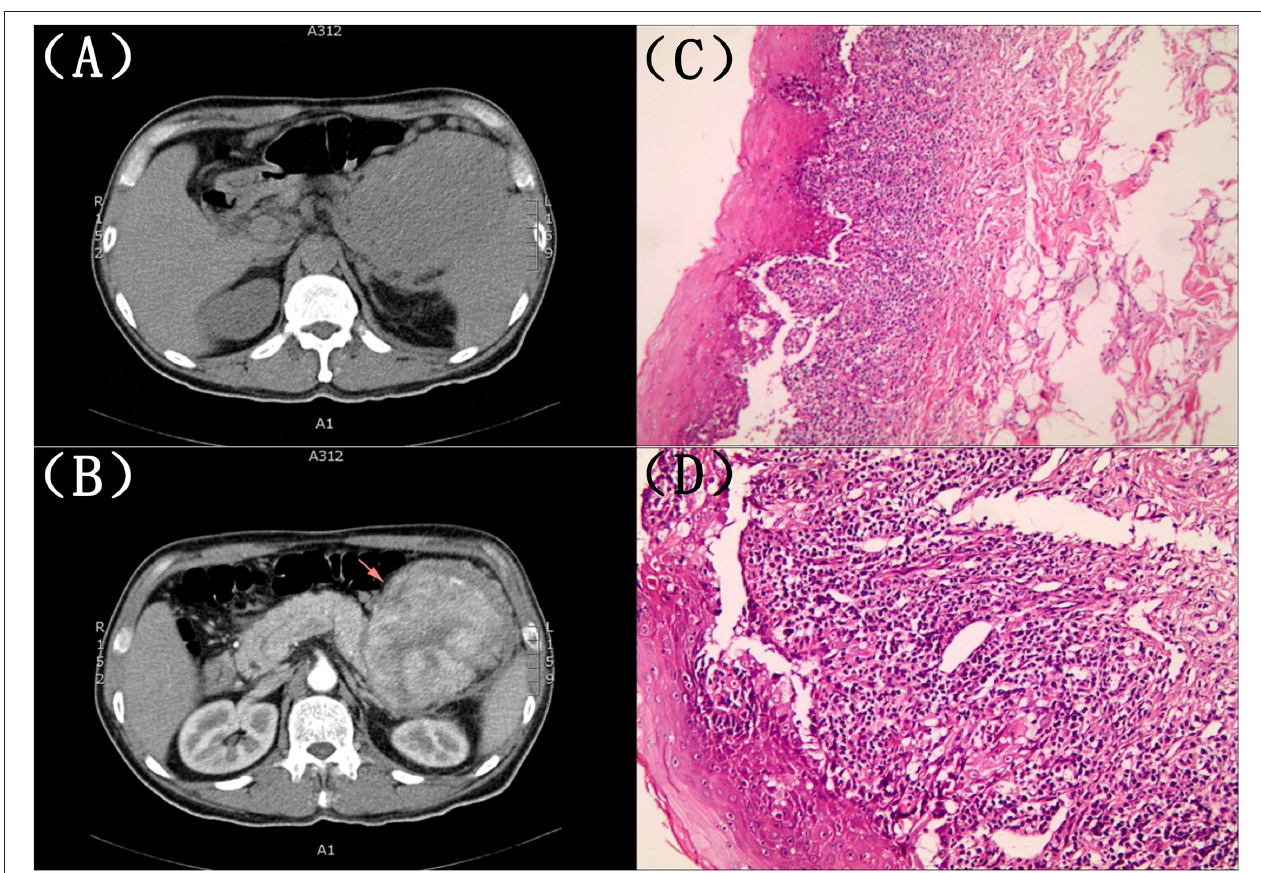
FIGURE 4 | (A,B) Computed tomography (CT) scan of the thorax and abdomen. A well-defined tumor between the spleen and stomach, measuring 117 × 108 × 91mm, accompanied by an abundant blood supply and enlarged retroperitoneal lymph nodes. (C,D) The histopathological evaluation of the skin lesions. Suprabasilaracantholysis, keratinocyte necrosis, basal layer damage, and inflammatory cell infiltration in the superficial dermis, including lymphocytes and plasma